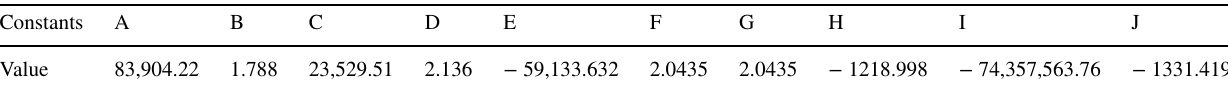
Table 9 The constants determined with n = 1.6